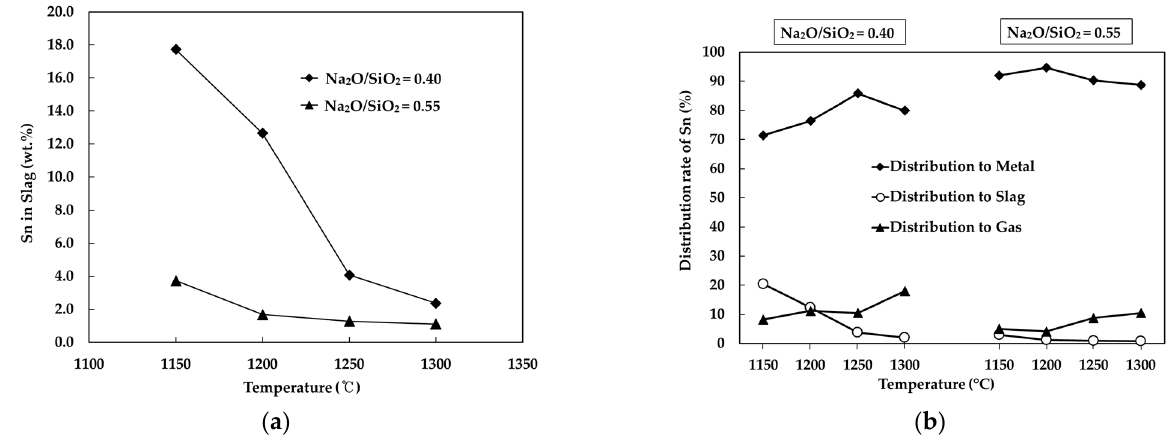
Figure 6. The effect of temperature ( a ) on the tin content in slag and ( b ) on the distribution of tin.